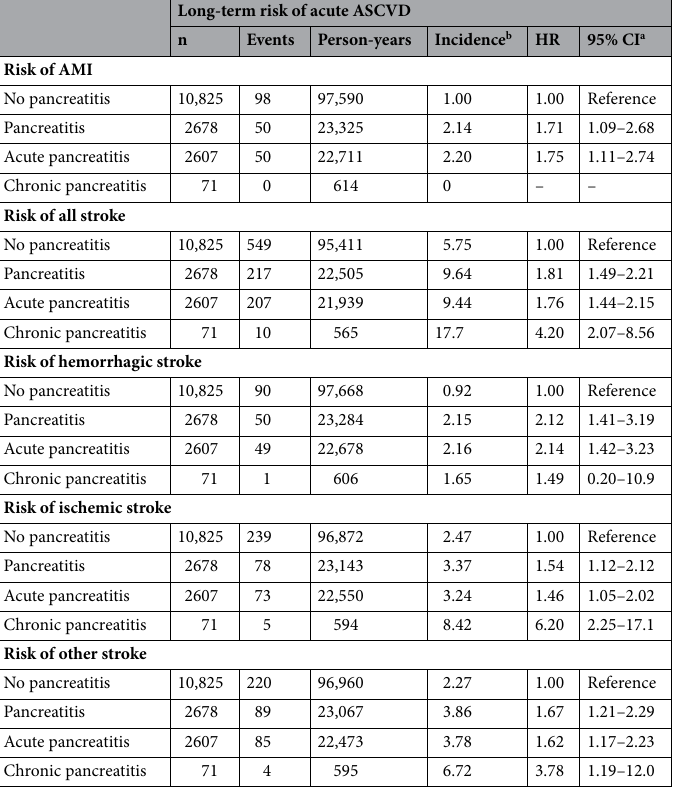
Table 4. Long-term risk of acute myocardial infarction and stroke in patient with pancreatitis. ASCVD atherosclerotic cardiovascular disease, AMI acute myocardial infarction, CI confidence interval, HR hazard ratio. a Adjusted for all covariates listed in Table 1. b Per 1000